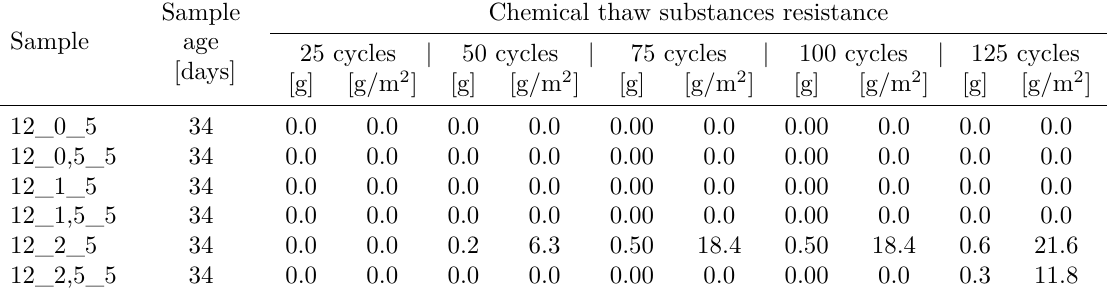
Table 10. Series no. 12 - Results of the resistance to chemical thaw substances tests.